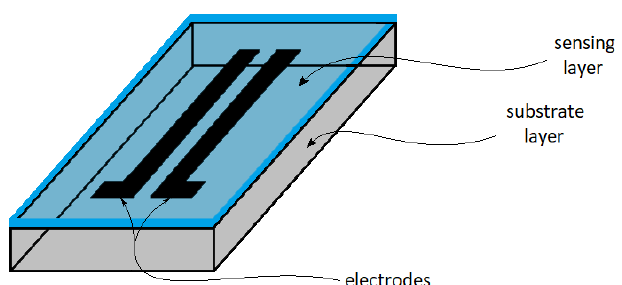
Figure 22. Simplified sensor configuration, with the substrate, electrodes, and sensing layer above them.